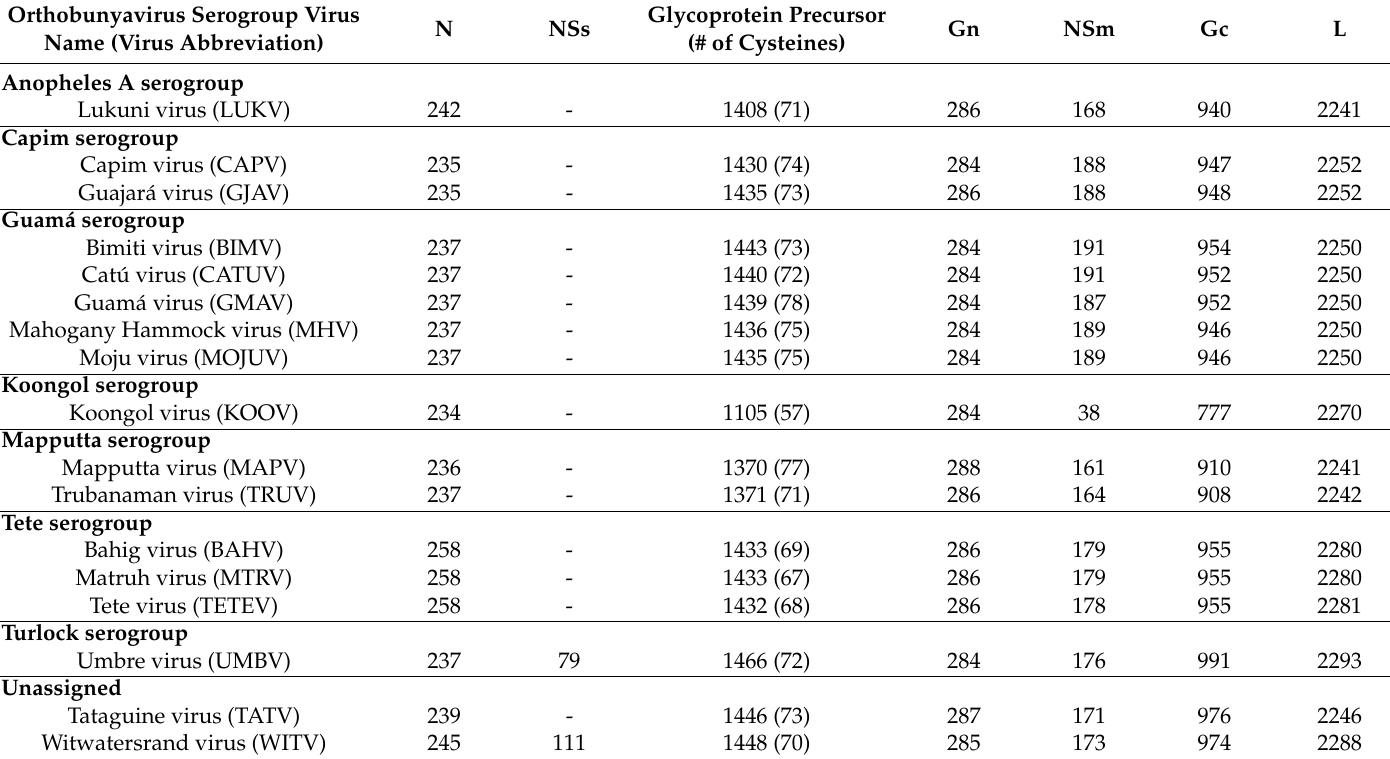
Table 2. Protein lengths of examined orthobunyaviruses (in amino acid residues)*. Orthobunyavirus Serogroup